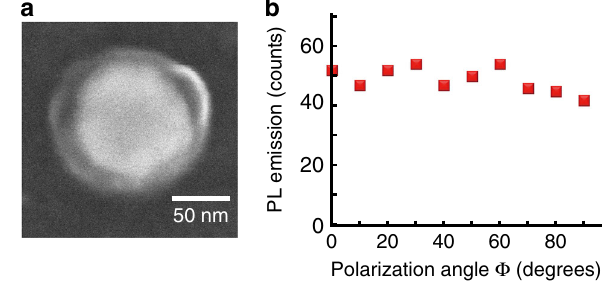
Fig. 6 Photoluminescence measurements on single hybrid nano-emitters. Hybrid nanosource based on Au nanodisk and CdSe/CdS/Zn quantum dots embedded in a nanometric polymer shell obtained by plasmonic 2-photon polymerization using circular polarization. a SEM image of the hybrid nanosource. b PL intensity as a function of the polarization angle ϕ of the blue excitation beam. λ = 405 nm, linear